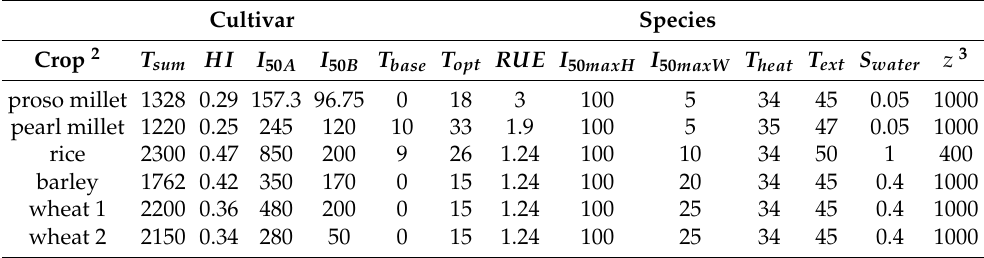
Table 2. Crop model parameters’ values used to configure crops in all experiments 1 . Cultivar